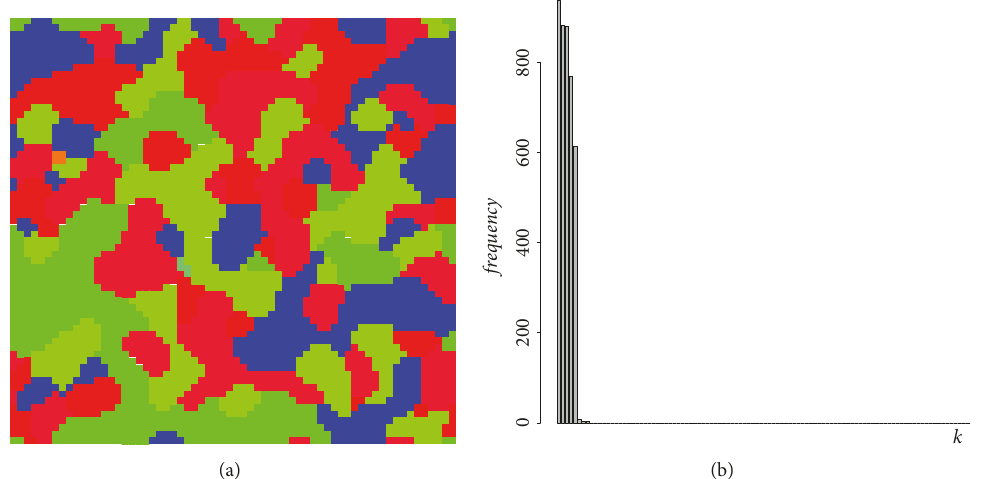
Figure 2: Example of a fixed point solution for 𝑠 = 2 , 𝑝 𝑎 = 0.25 , and 𝑝 𝑏 = 0.75 . (a) The spatial patterns of selected schools (the colormap labels the states {1,2,. .. 100} ). (b) The distribution of the number of students per